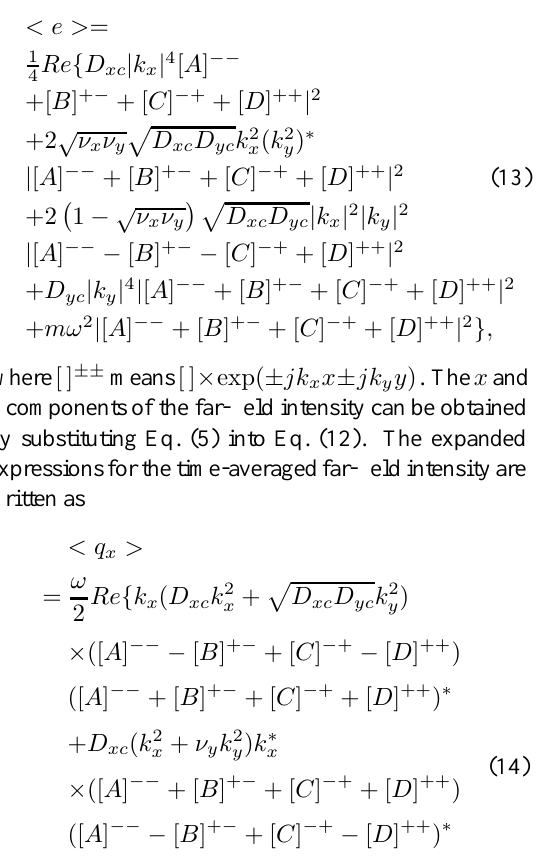
Fig.10. The approximate intensity field in the orthotropic plate when f = 500 Hz and η = 0 . 2